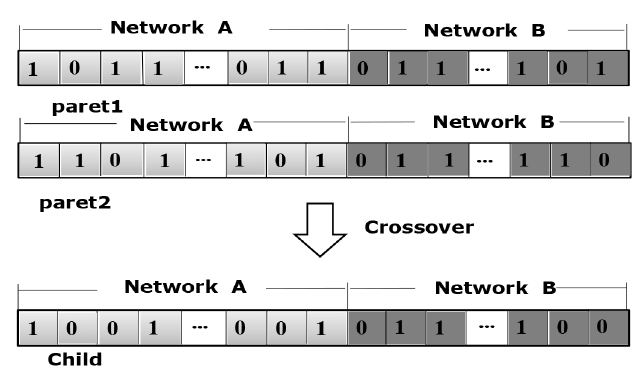
Figure 1. Genetic algorithm multipoint